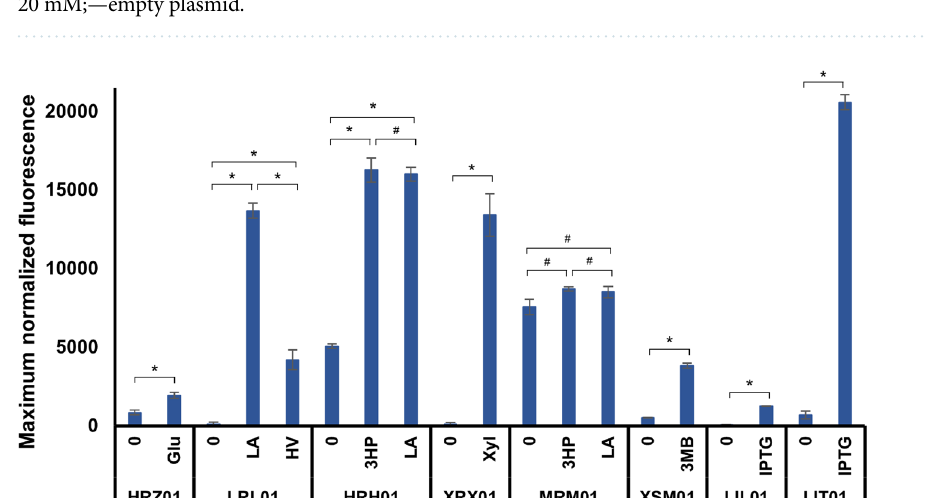
Figure 3. Efficiency of different promoter systems and comparison with chemical inducible systems. Maximum normalized fluorescence was calculated with the saturating concentration of the respective inducers and compared with the control condition (without inducer) and against IPTG (P LlacO1 and P tac )- and 3 MB (P m )- inducible systems. IPTG and 3 MB were used at 0.5 mM. 0, no inducer; Glu, glucose; LA, levulinic acid;